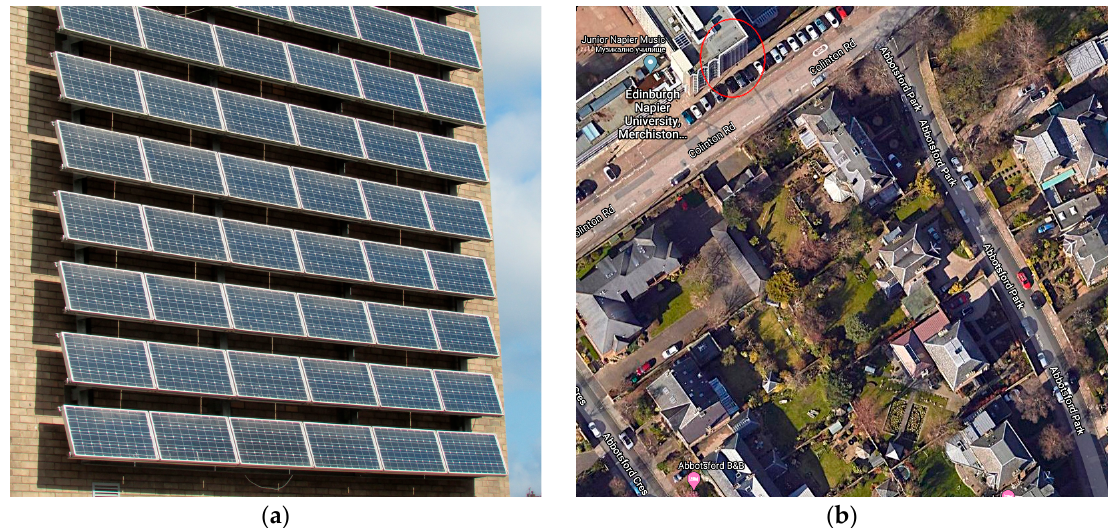
Figure 2. Edinburgh Napier University (ENU) Building-Integrated Photovoltaic (BIPV) installation: ( a ) street view of BIPV installation and ( b ) plan view of ENU-BIPV: roof area = 3766 m 2 , road area = 3041 m 2 , and grass/tree-top area = 7885 m 2 .